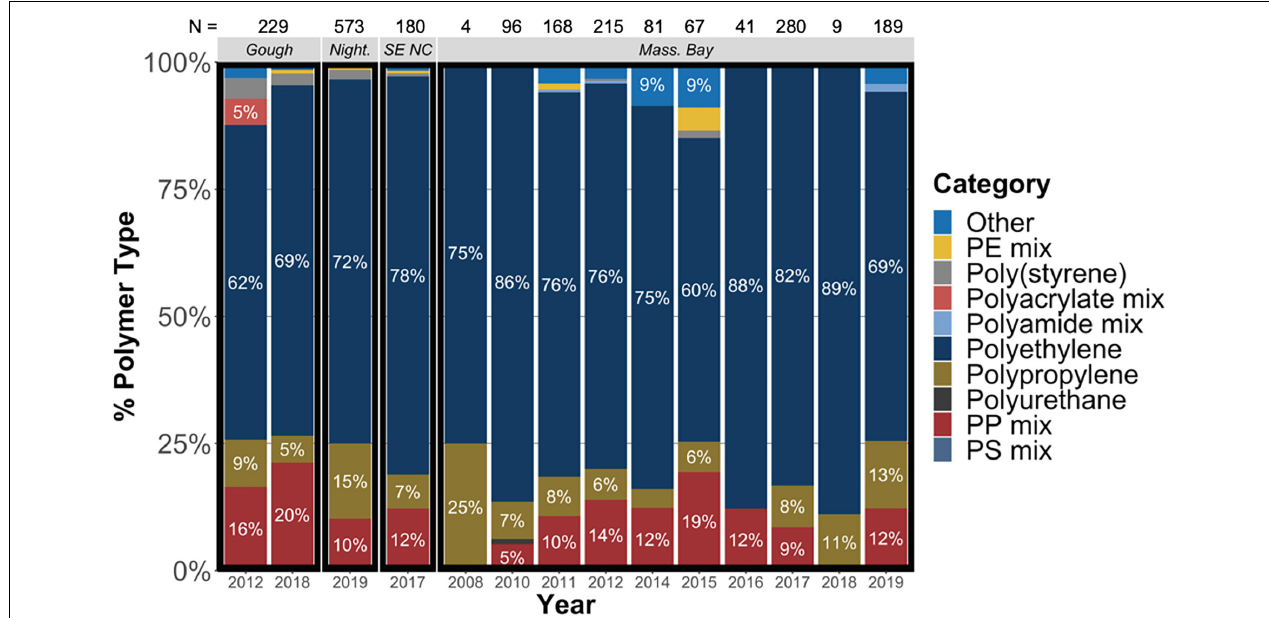
FIGURE 5 | Polymer composition of plastic items ingested by Great Shearwater Ardenna gravis grouped by year and sampling location. Night. = Nightingale Island; SE NC = Southeast North Carolina, United States; Mass. Bay = Massachusetts Bay, United States; N = number of plastic items